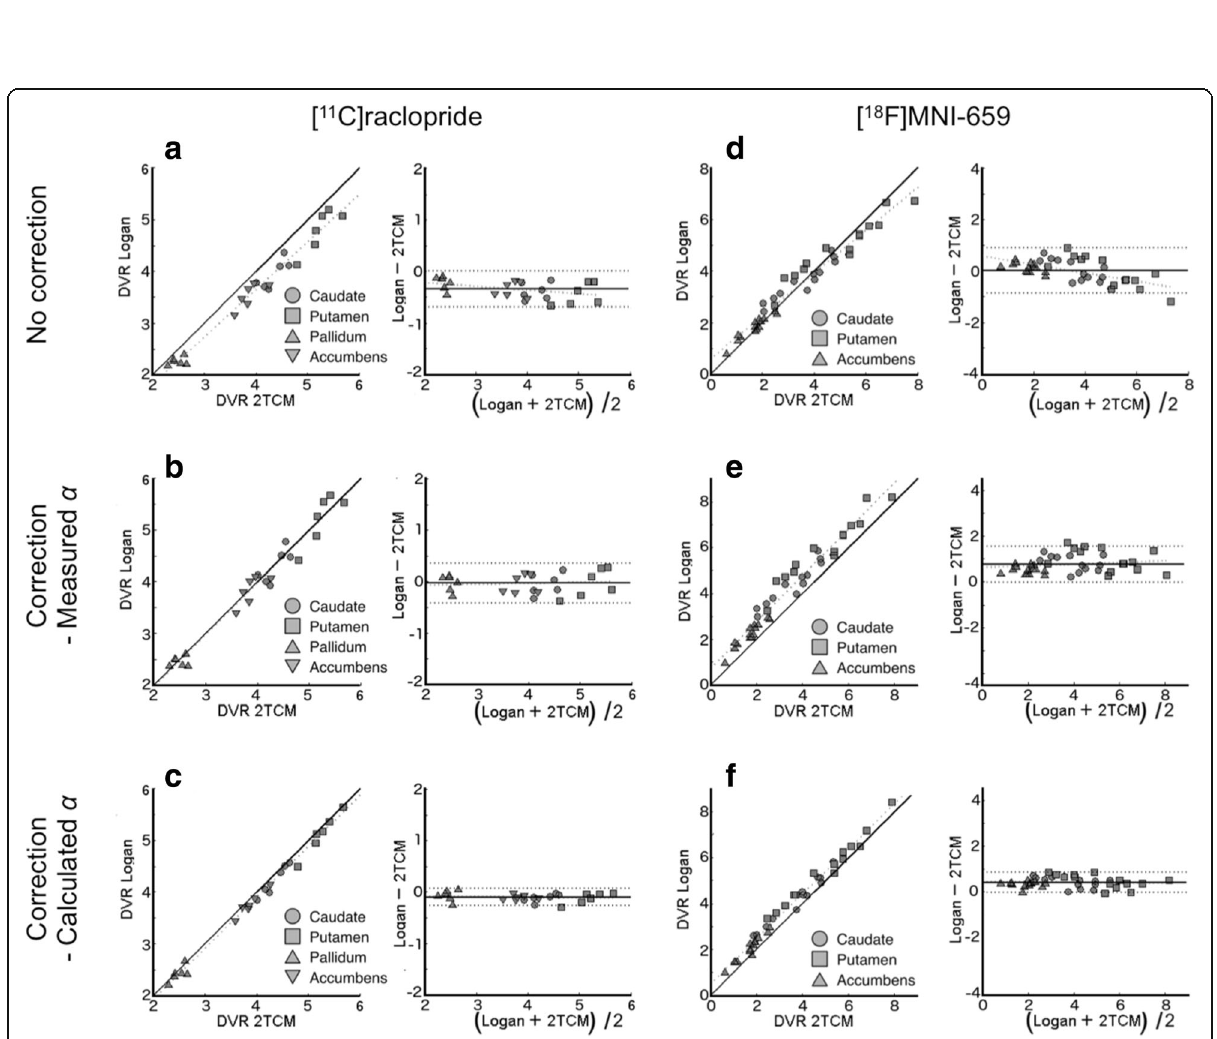
Fig. 5 Distribution volumes ratios (DVR) obtained with 2TCM plotted against those obtained with Logan ref, and corresponding Bland-Altman plots. DVRs from Logan ref. are: not corrected ( a , d ), corrected using measured values for α ( b , e ), and calculated values for α ( c , f ). Left column ( a , b , c ) shows [ 11 C]raclopride data, and right column ( d , e , f ) shows [ 18 F]MNI-659